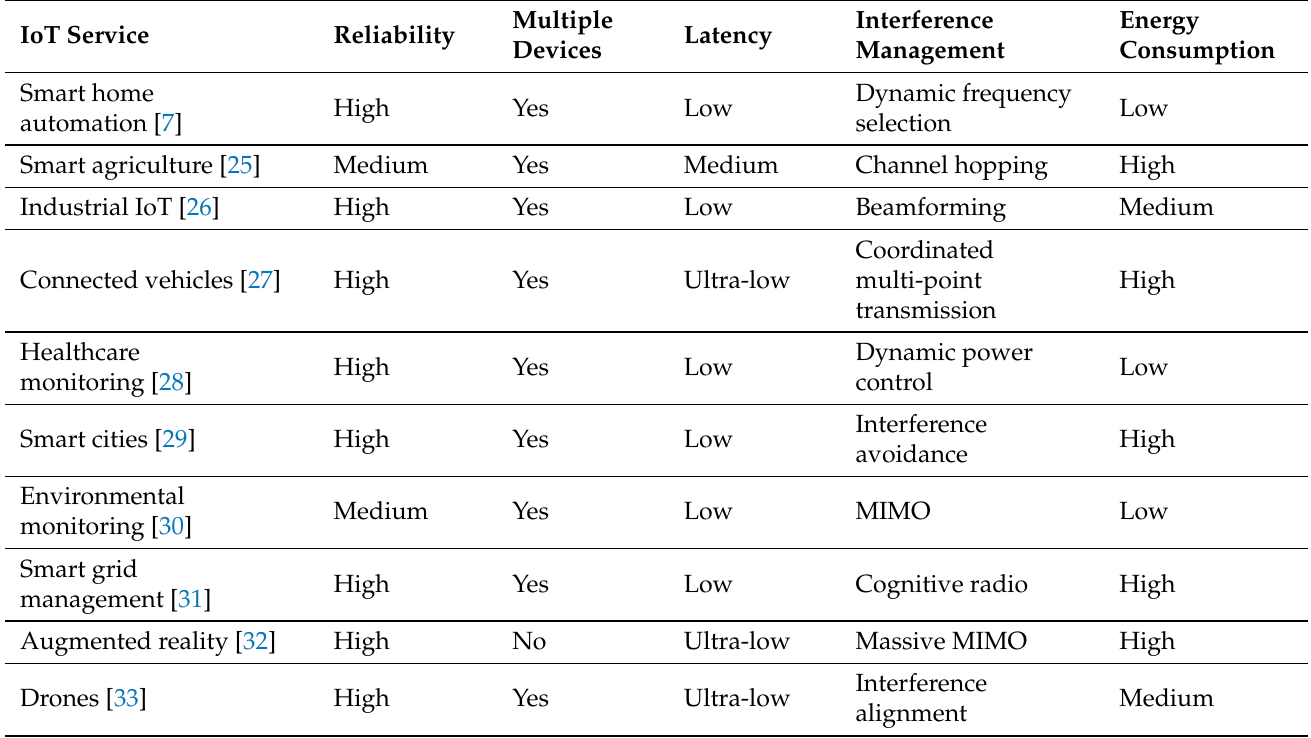
Table 1. Impact of 5G network interference on IoT